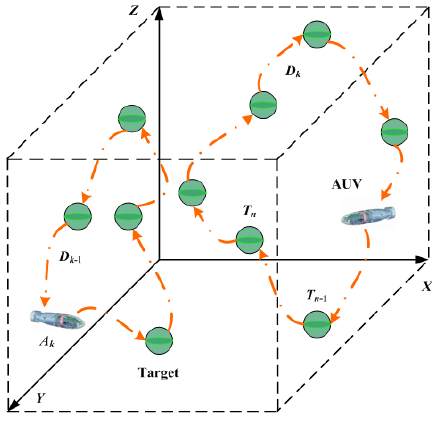
Figure 1. Targets tracking with multiple AUVs. Table 1. List of